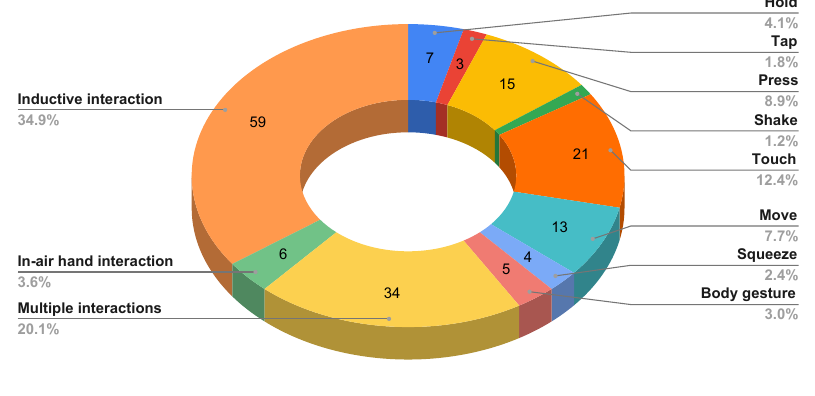
Figure 2. Interaction with tangible light in the review